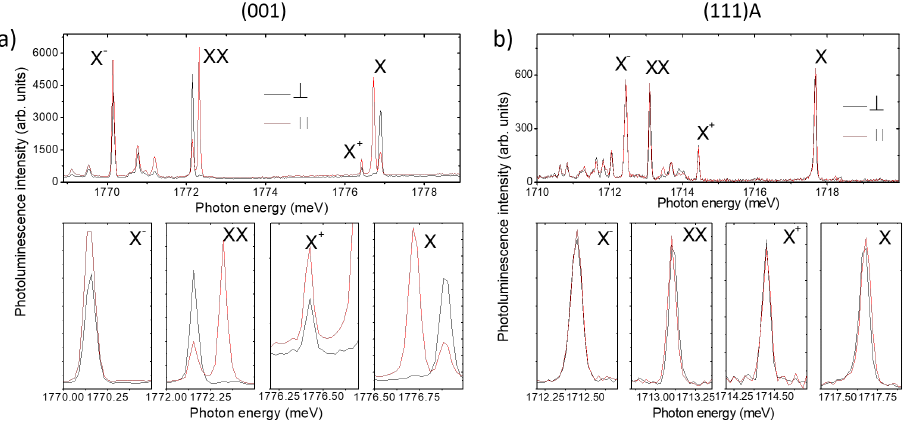
Figure 3. ( a ) Top panel: photoluminescence (PL) spectrum of a QD grown on the (001) surface for the sample described in reference [71]. The main excitonic recombination lines from the s-shell are highlighted. Red and black lines represent the orthogonally and linearly polarized components of the PL, respectively, oriented along the crystallographic axes [ − 110] and [1–10]. Bottom panels: From the left to the right panel are magnifications of each individual line in the spectrum: X − , XX, X, and X + for both linearly polarized components, respectively. ( b ) The same as for (a) but for a QD grown on the (111)A-oriented